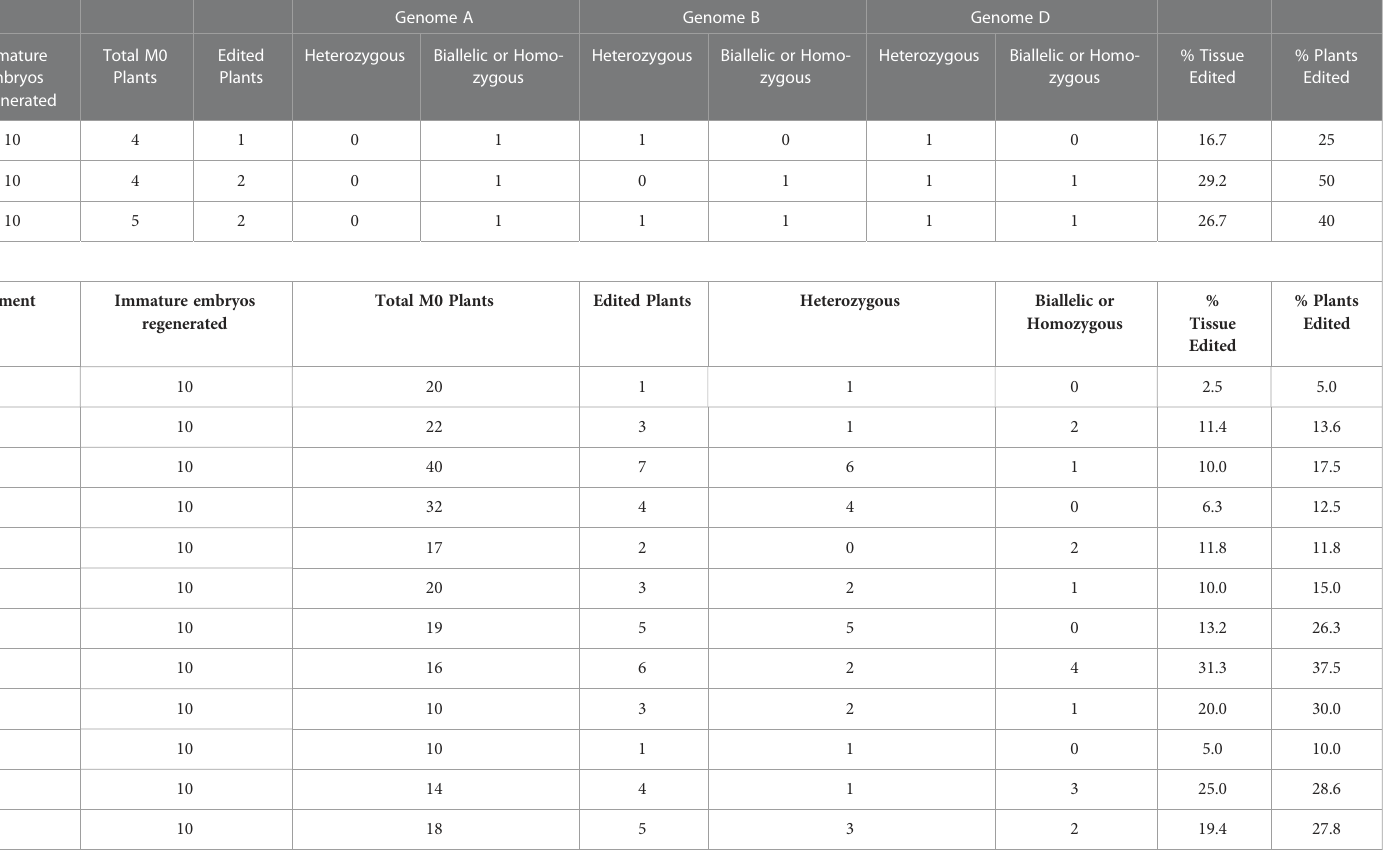
TABLE 1 Summary of editing outcomes in Pi21, Tsn1, and Snn5 targeted M0